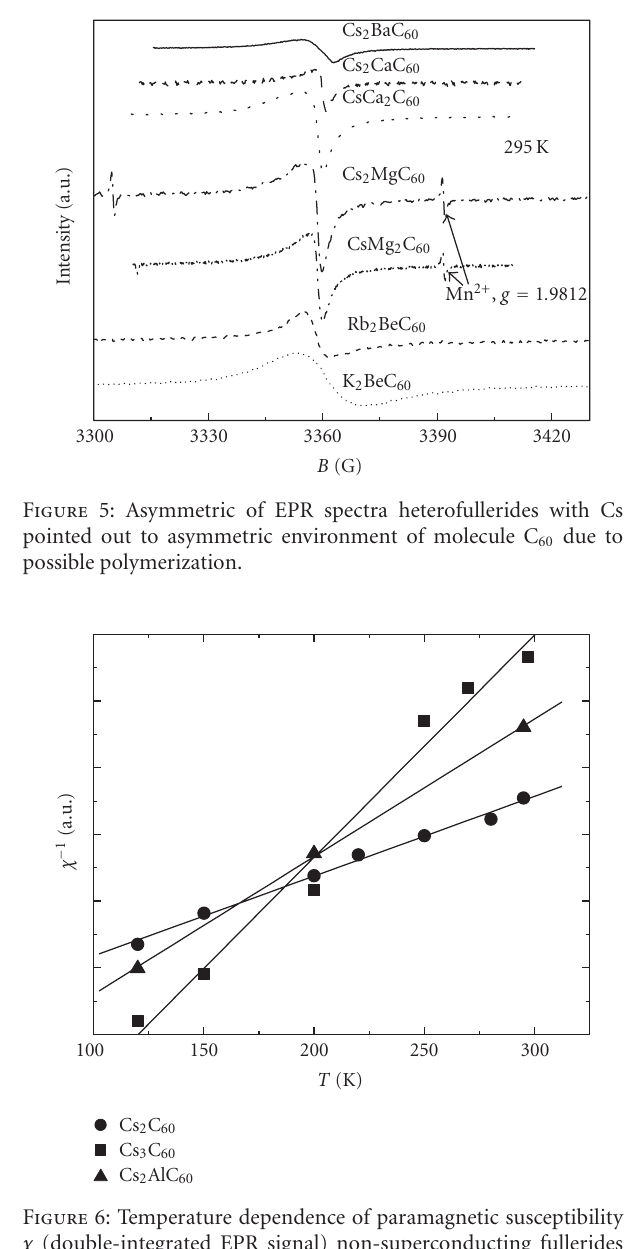
Figure 6: Temperature dependence of paramagnetic susceptibility χ (double-integrated EPR signal) non-superconducting fullerides with Cs. Curie-Weiss law (fitting by solid lines) is a consequence of the absence of conduction electrons (no contribution to the paramagnetic